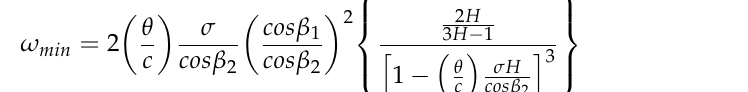
Figure 13. Comparison of Mach number contours at 10% spanwise location. ( a ) Clean sector at DIS; ( b ) clean sector at COUP; ( c ) distortion sector at DIS; ( d ) distortion sector at COUP.